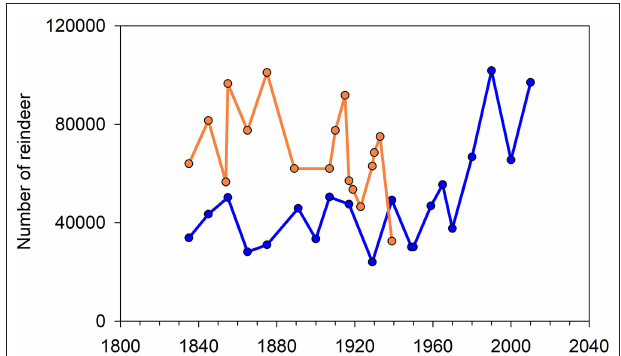
FIGURE 23 | Contrasting accounts of the development of numbers of reindeer in West Finnmark reindeer pasture area ( Figure 3 ) across the last two centuries. The lower curve (blue) is based on official records (Tømmervik and Riseth, 2011) while the upper curve (orange) is based on herders’ estimates (Sara et al., 2016). Sara et al. (2016) attribute the difference between the level of the two curves to herders’ reluctance to declare the true size of their herds, leading to chronic underestimation of numbers in the official record (blue) before relatively rigorous counting procedures were introduced toward the end of the 20 th Century. The accuracy of neither herders’ estimates nor official records before then is known.